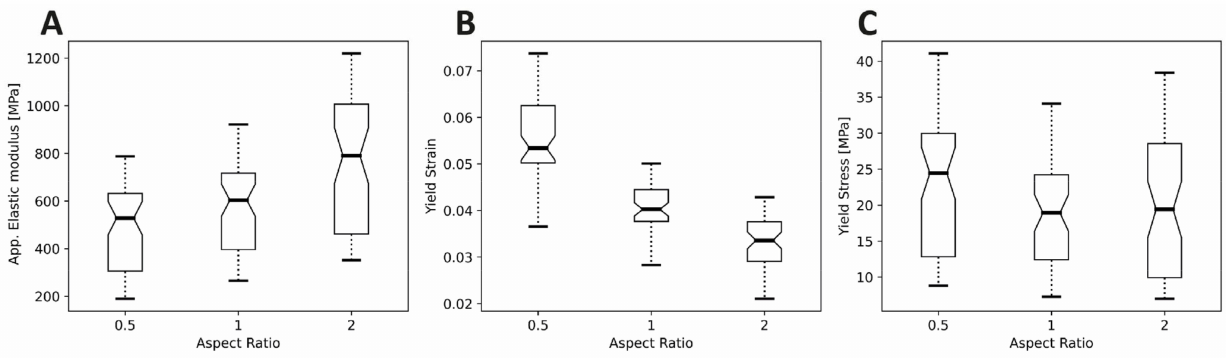
Figure 7. Mechanical analysis of the scaffold test specimens with respect to the H/D ratio: ( A ) Apparent Elastic modulus, ( B ) Yield Strain and ( C ) Yield Stress. Data are presented as notched box plots. Boxes represent the second and third quartile around the median, which is represented by the thick horizontal line within the block. Whiskers represent 100% of the data within each group, including outliers. Notches represent a 95% confidence interval (CI notch ) of the median and extend to [ ± 1.58 × IQR/(( n ) 0.5 )]. IQR = interquartile range between first to third quartile and “ n ” =